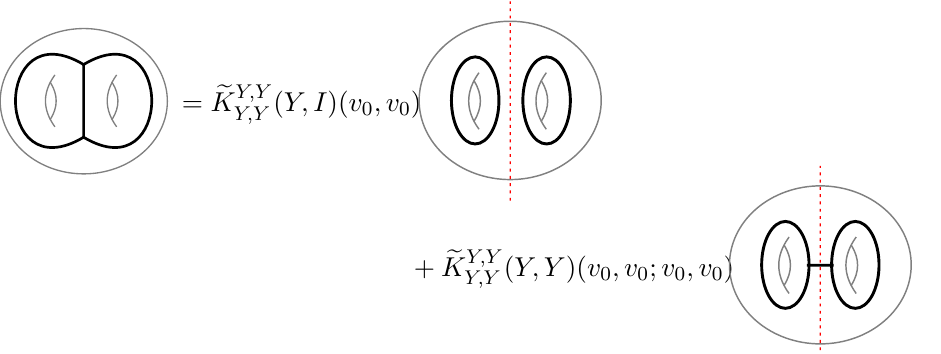
Figure 60 . Lassoing of bulk and defect operators in the 1 pendent lasso diagrams here, as the rest can be obtained by unwrapping the loop on the sphere.